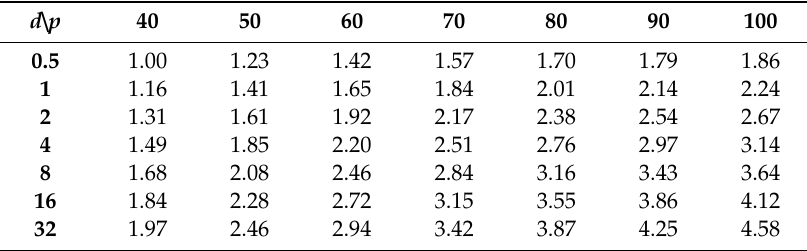
Figure 14. ESA gain for each p -story SB, starting from d = 0.5 km. Table 3. ESA gain mapping.